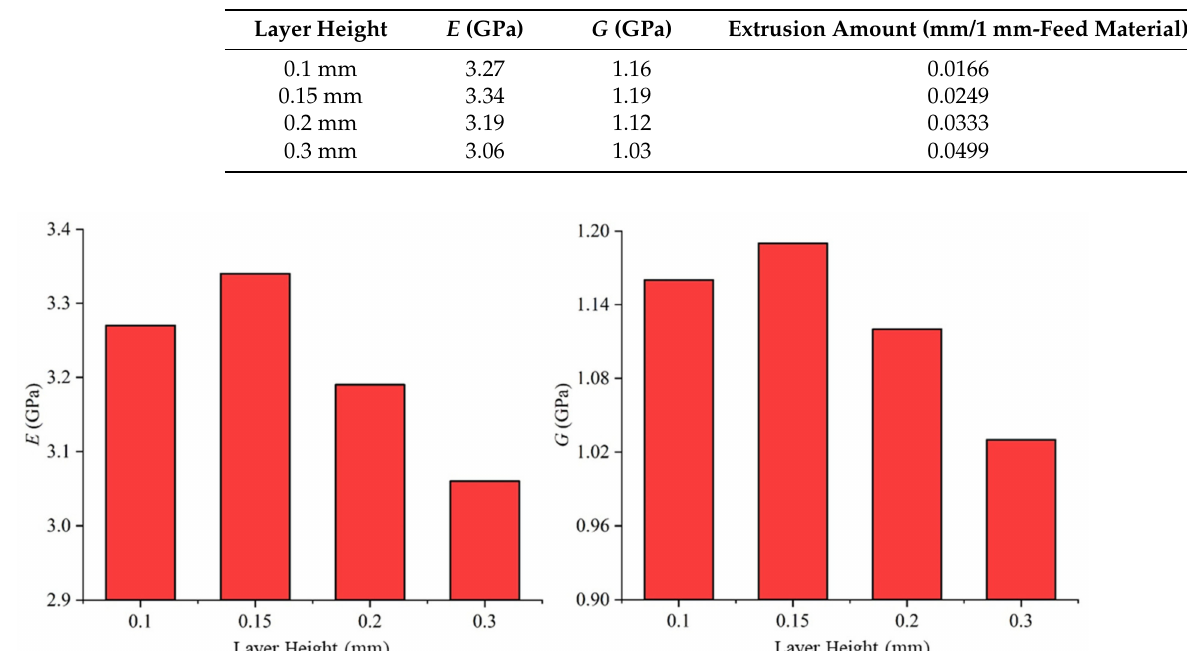
Figure 11. Material constants of test pieces with different layer